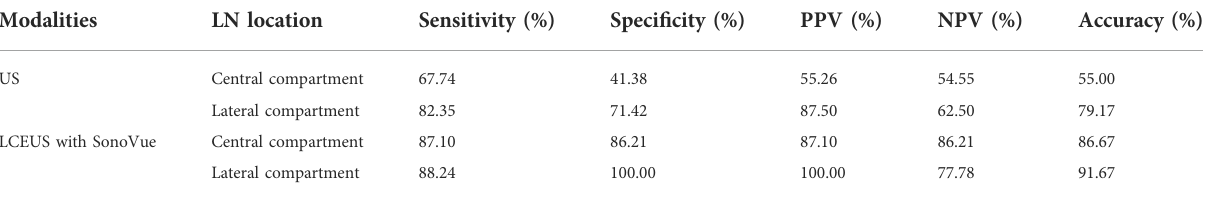
TABLE 1 Diagnostic performance of US and LCEUS with SonoVue for LNM in the central and lateral cervical compartments.